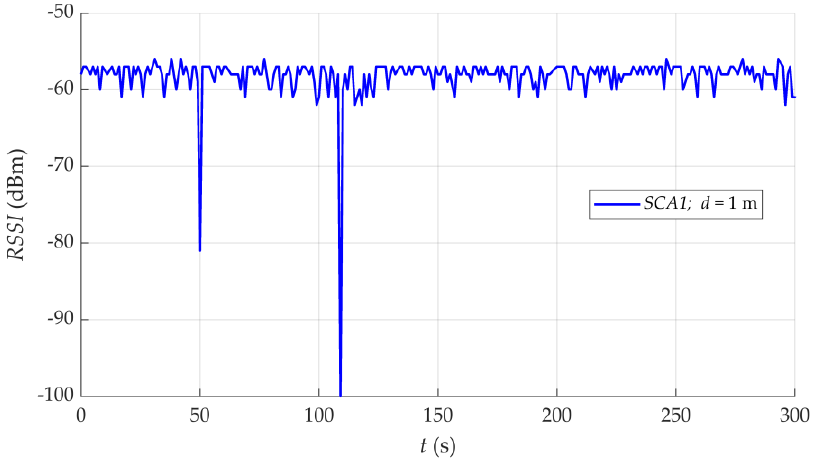
Figure 10. Examples of outliers in RSSI measurements.